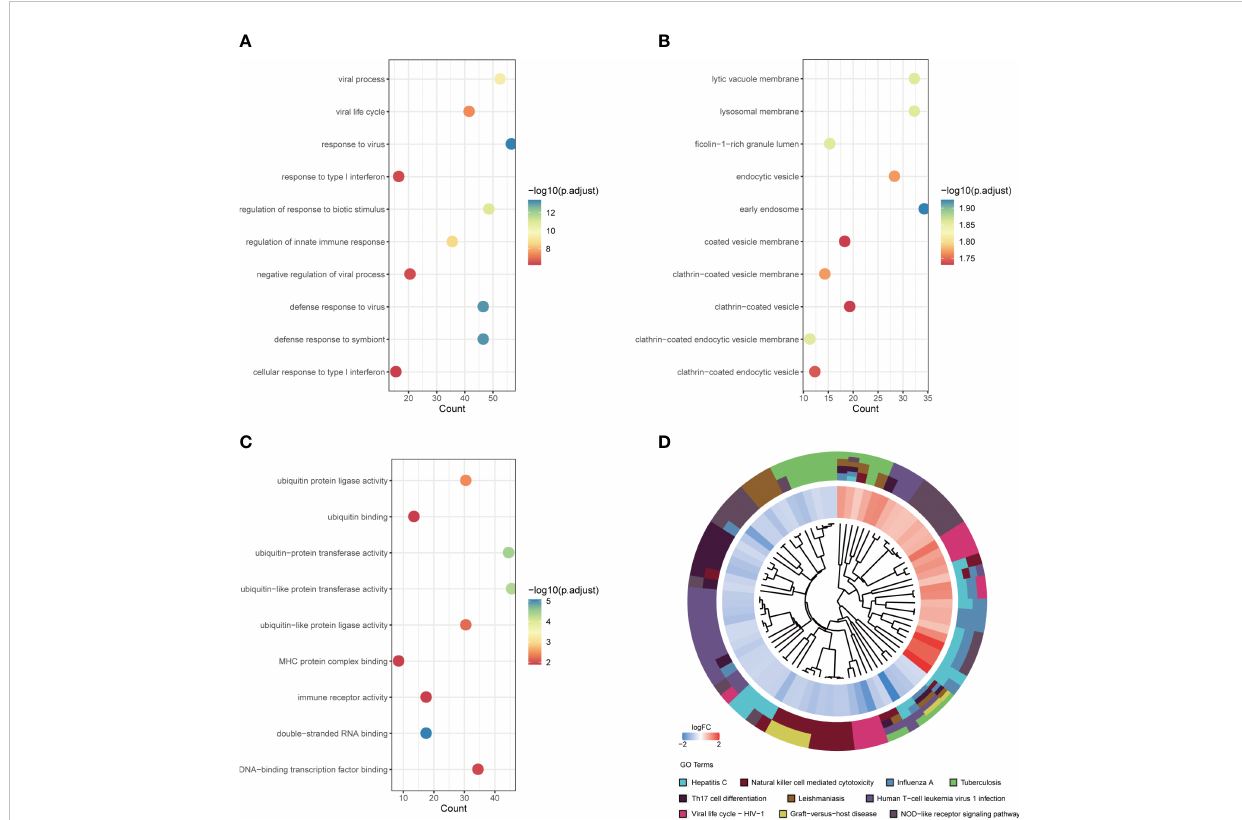
FIGURE 3 Functional annotation and pathway enrichment of DEGs. (A) Top 10 GO BP pathway; (B) Top 10 GO CC pathway; (C) Top 10 GO MF pathway; (D) Top 10 KEGG pathway. DEGs, differentially expressed genes; GO, gene ontology; BP, biological process; CC, cellular component; MF, molecular function; KEGG, Kyoto encyclopedia of genes and genomes.